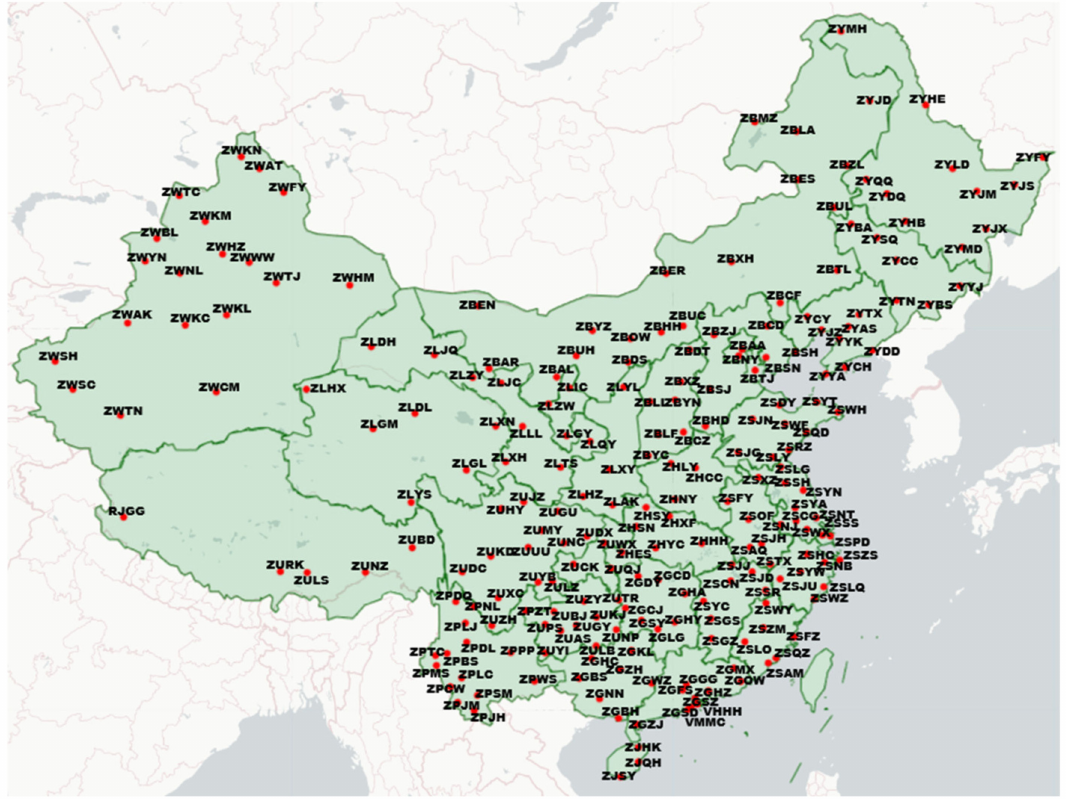
Figure 10. Location distribution map of 219 major airports in